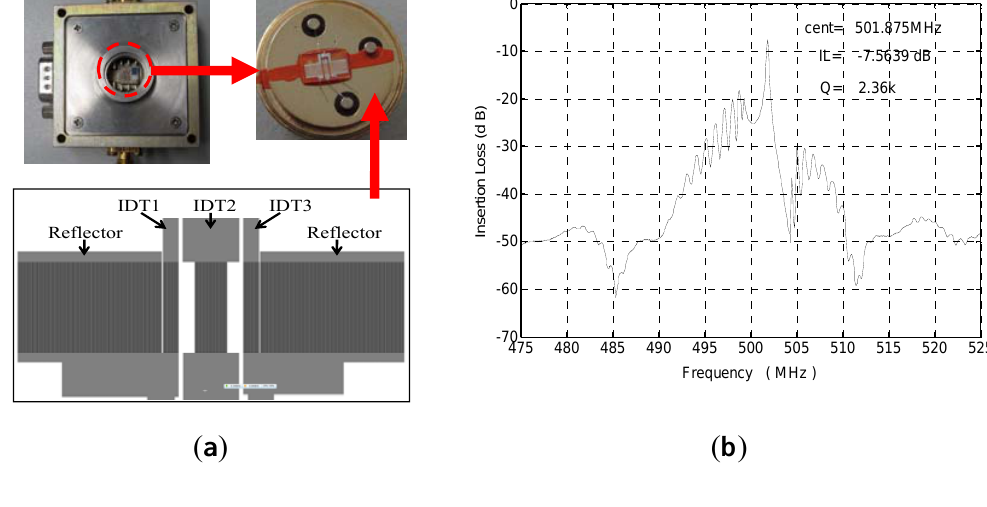
Figure 5. ( a ) The structure of the SAW device, and ( b ) the frequency response of the fabricated